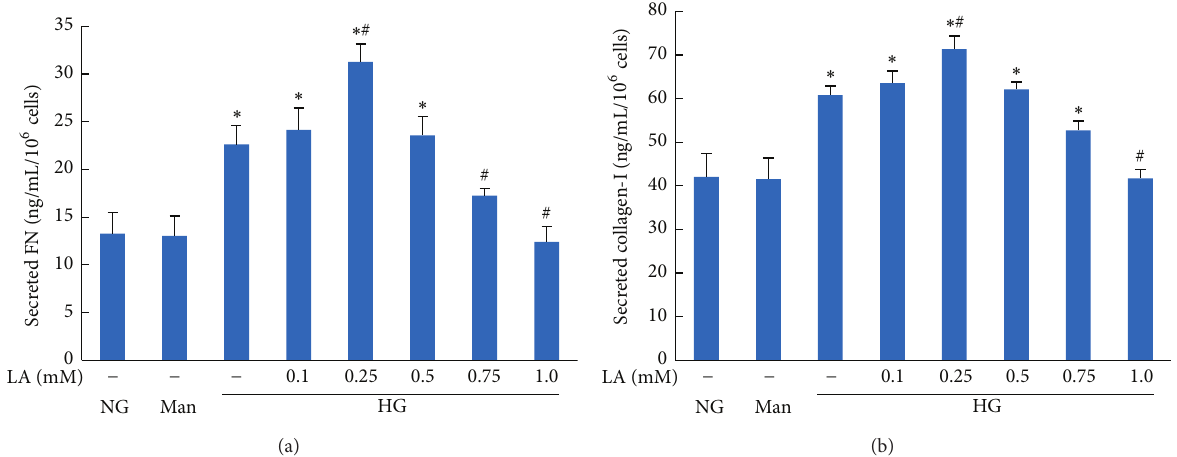
Figure3:EffectofLAonthesecretionsofFNandcollagen-Iinhighglucose-treatedmesangialcells.SupernatantswereassayedbyELISAafter treatment with different concentration of LA for 24 hours. Values are given as mean ± SD from 3 independent experiments in quadruplicate and 𝑃 < 0.05 is considered statistically significant. Note: ∗ 𝑃 < 0.05 versus NG; # 𝑃 < 0.05 versus HG. Abbreviations: NG, normal glucose (5mM); Man (5 mM glucose + 25 mM mannitol); HG, high glucose